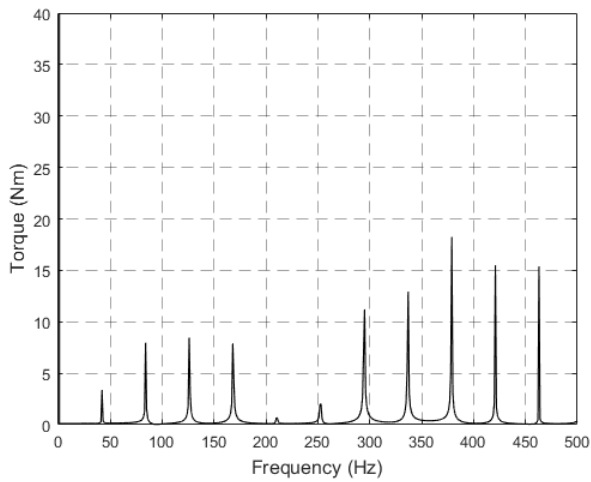
Figure 17. The torque amplitude frequency spectrum, basic DTC scheme, f ∈ (0, 500 Hz). ω m ∗ = 0.5 ω n .